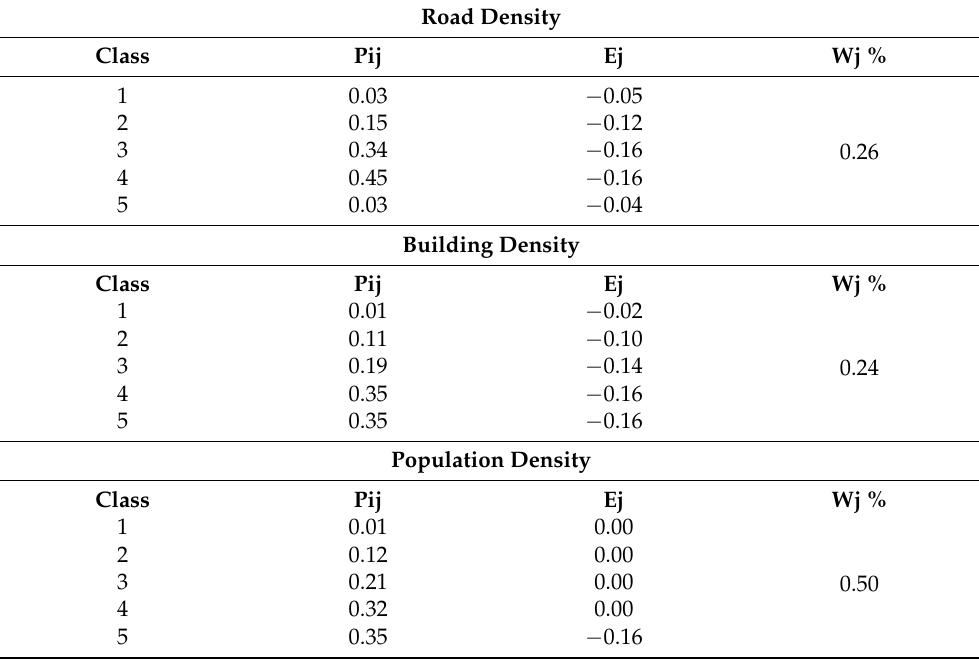
Table 10. Weights given to vulnerability factors of SE